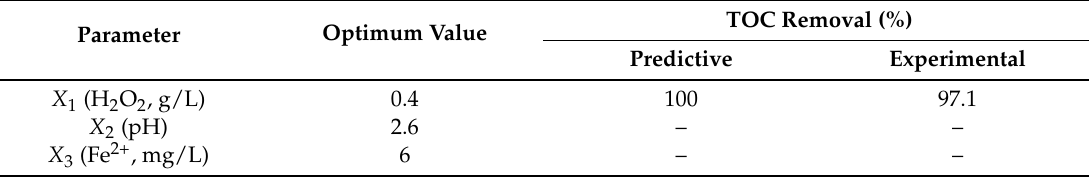
Table 4. Comparison of the predictive and the experimental result optimum values of TOC